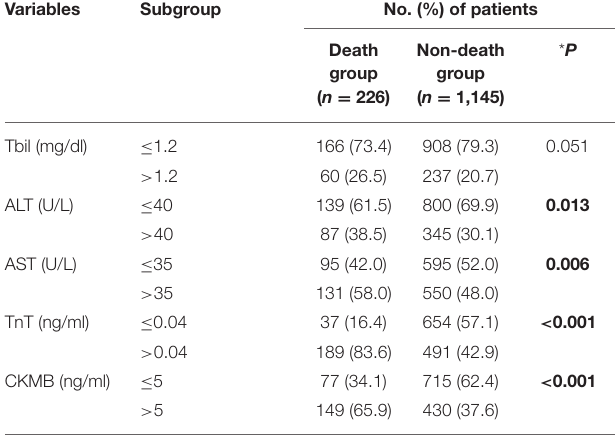
TABLE 2 | Clinical characteristics among the AHF death group and non-death group in the training